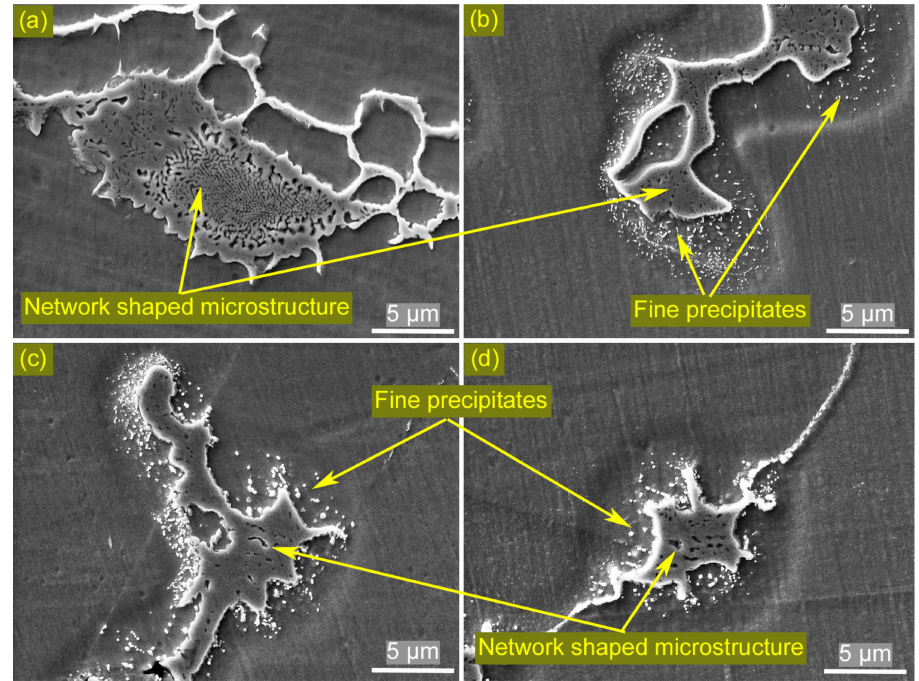
Figure 6. Microstructure images obtained by SEM after thermal simulations with two thermal cycles. The peak temperature of the second thermal cycle T p2 was 1100 ◦ C and the holding time t p2 were ( a ) 1 s, ( b ) 5 s, ( c ) 10 s, and ( d ) 20